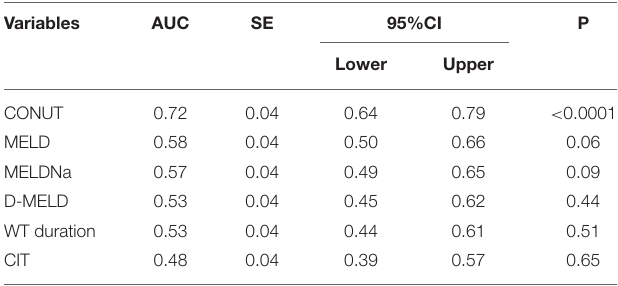
TABLE 5 | C-statistics for the evaluation of CONUT performance for the diagnosis of CCI 42.1. ≥